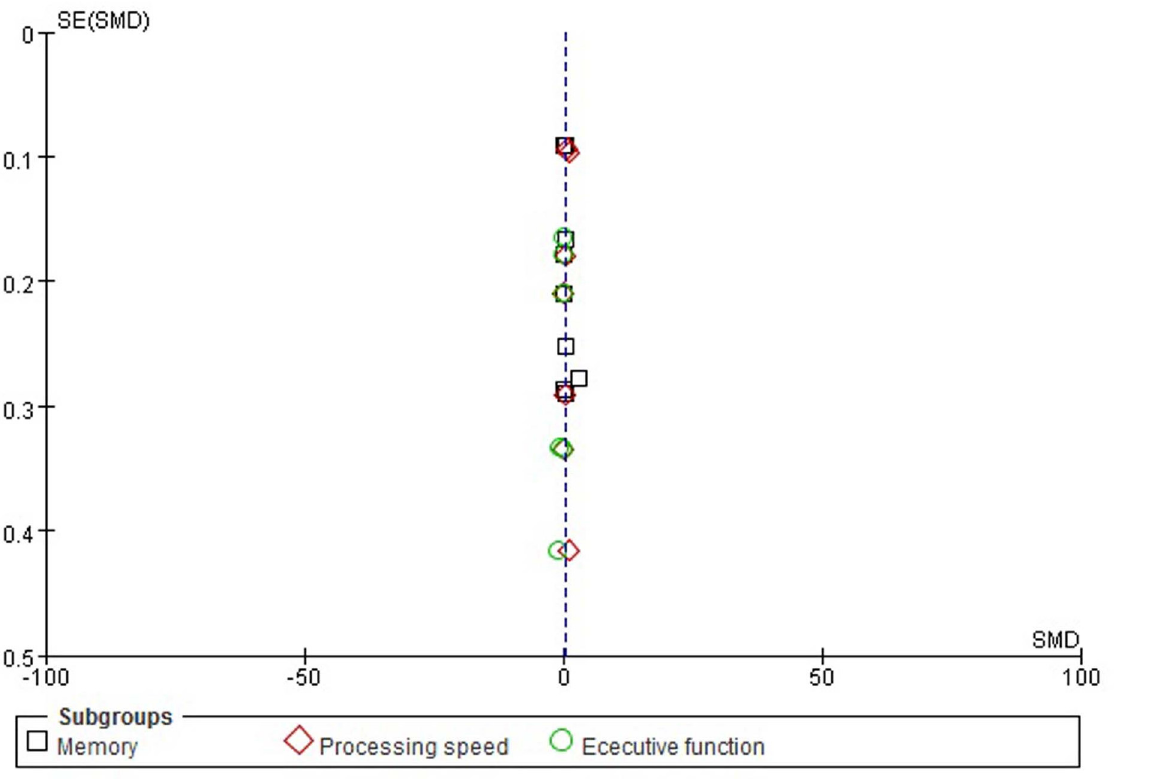
Fig 7. Funnel plot for memory, processing speed, and executive